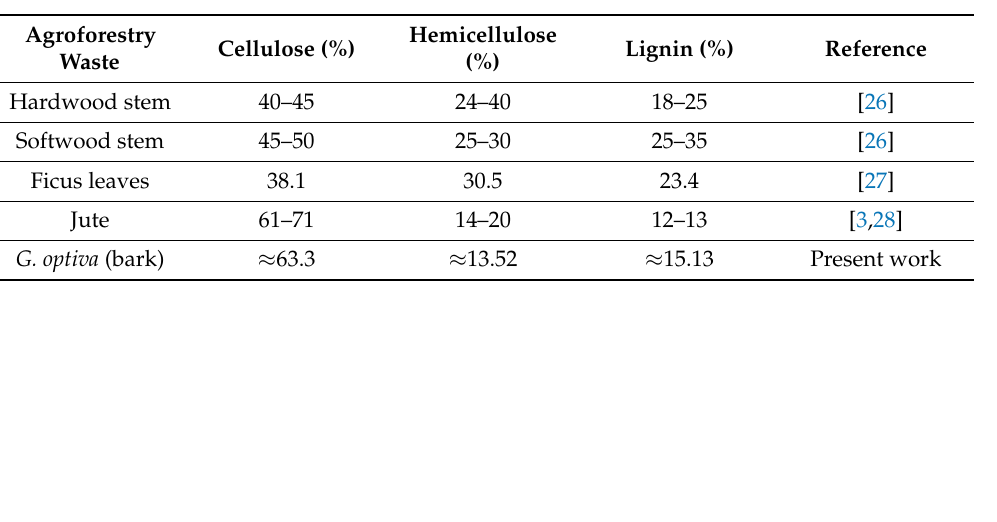
Table 1. Comparison of the chemical composition of some important agroforestry